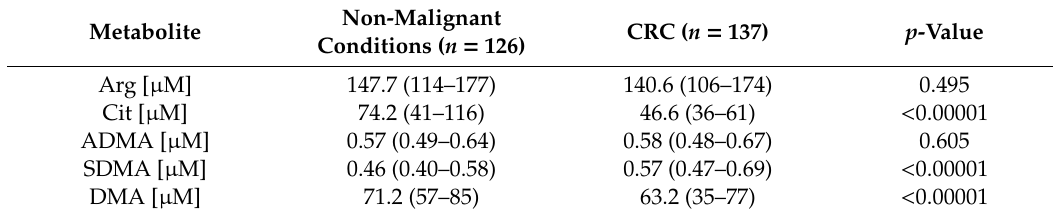
Table 4. Comparison of pathway metabolites in CRC and non-malignant bowel